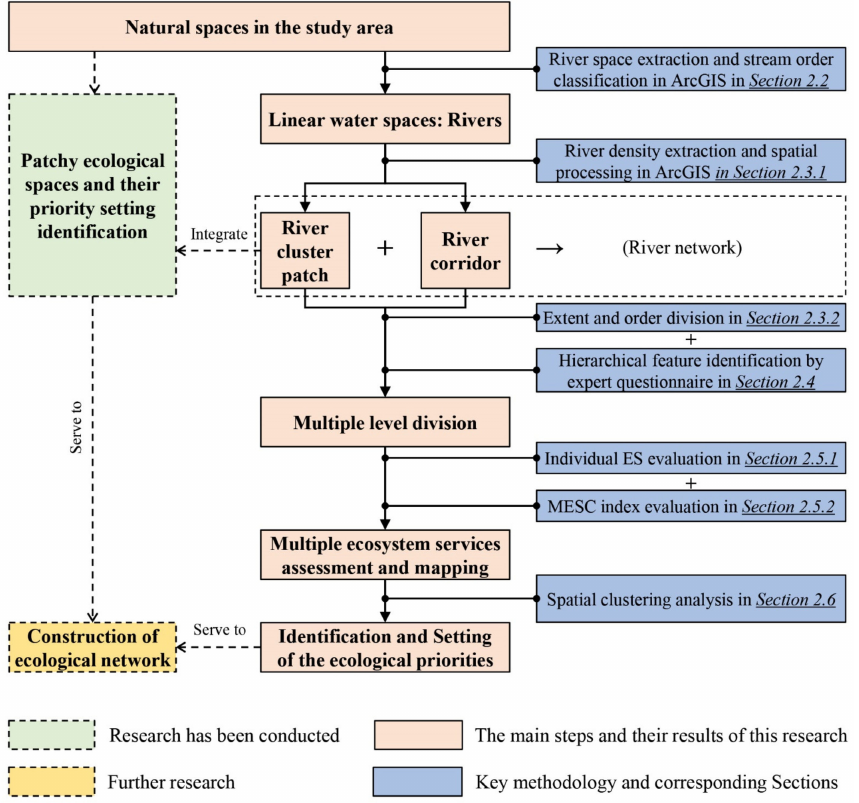
Figure 1. Technical and methodological